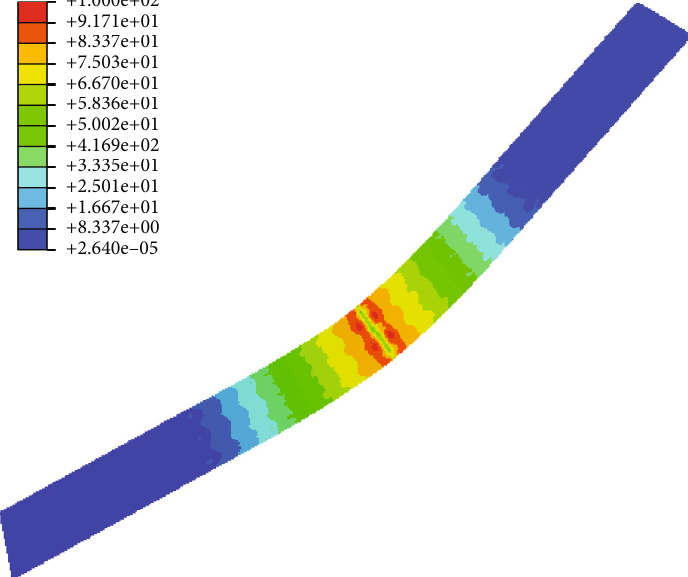
Figure 9: Stress (( S , miss/MPa)) nephograms of upper panel belong to actual